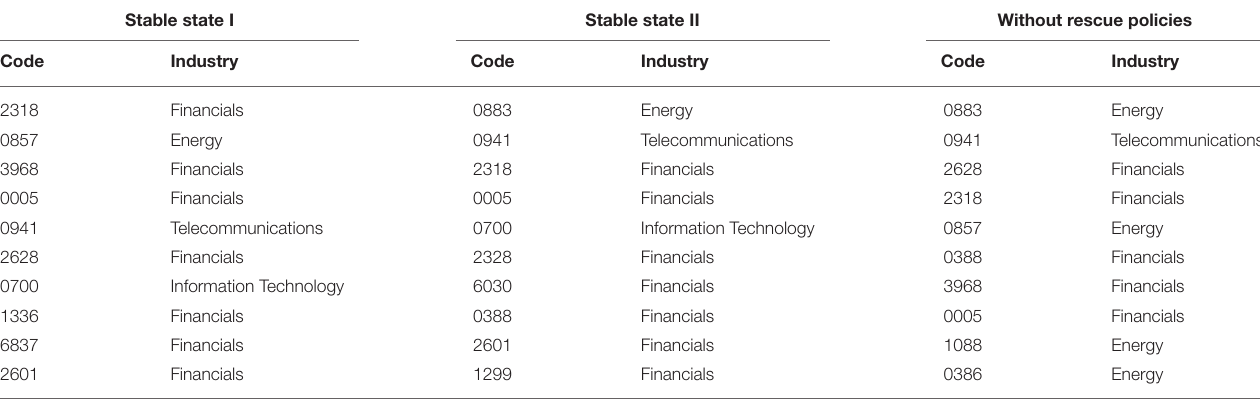
TABLE 7 | Top 10 stocks with the highest mean value of degrees in the stock network for the two stable-state sub-periods and the sub-period without rescue policies in the Hong Kong stock market. Stable state I